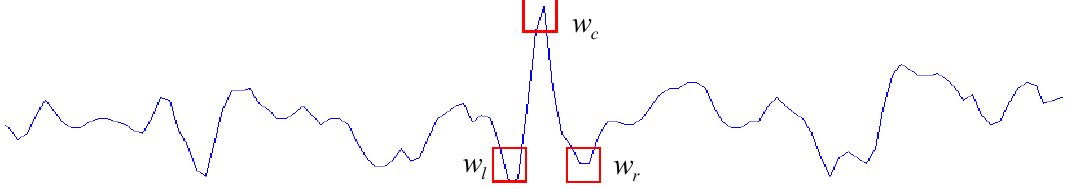
Figure 7. Schematic diagram of a power line feature extraction operator.